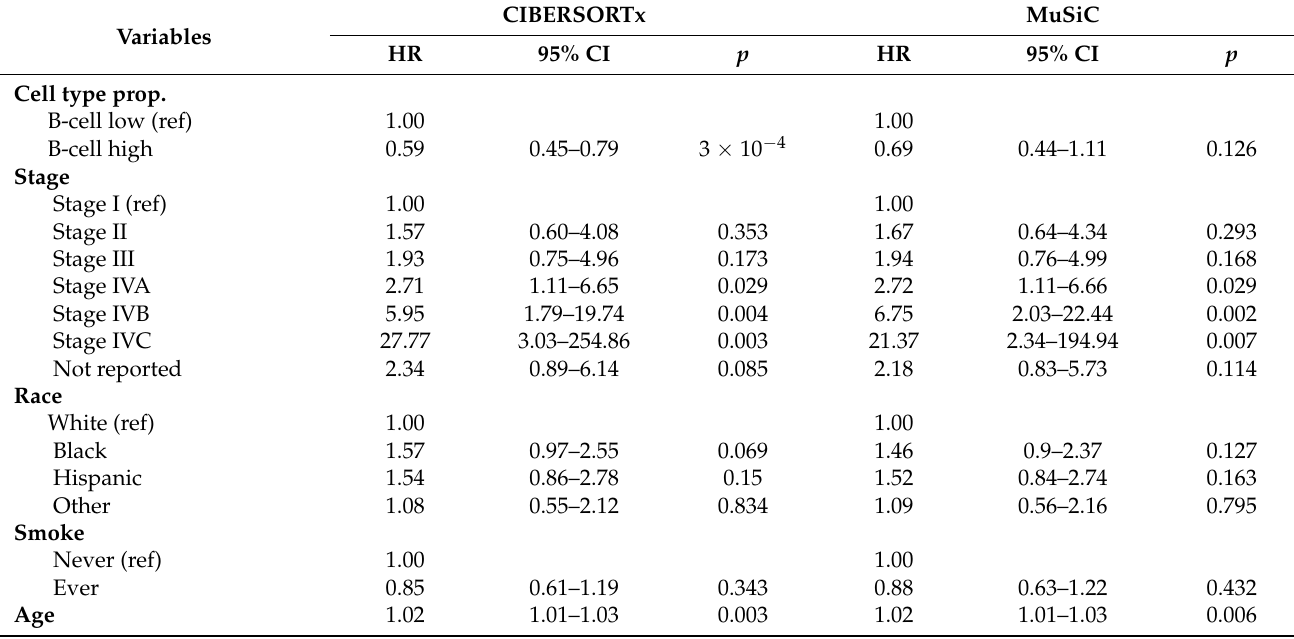
Table 2. Cox proportional-hazard regression analysis for survival and B-cell proportions estimated by CIBERSORTx and MuSiC (prop., proportion; HR, hazard ratio; CI, confidence interval; ref,